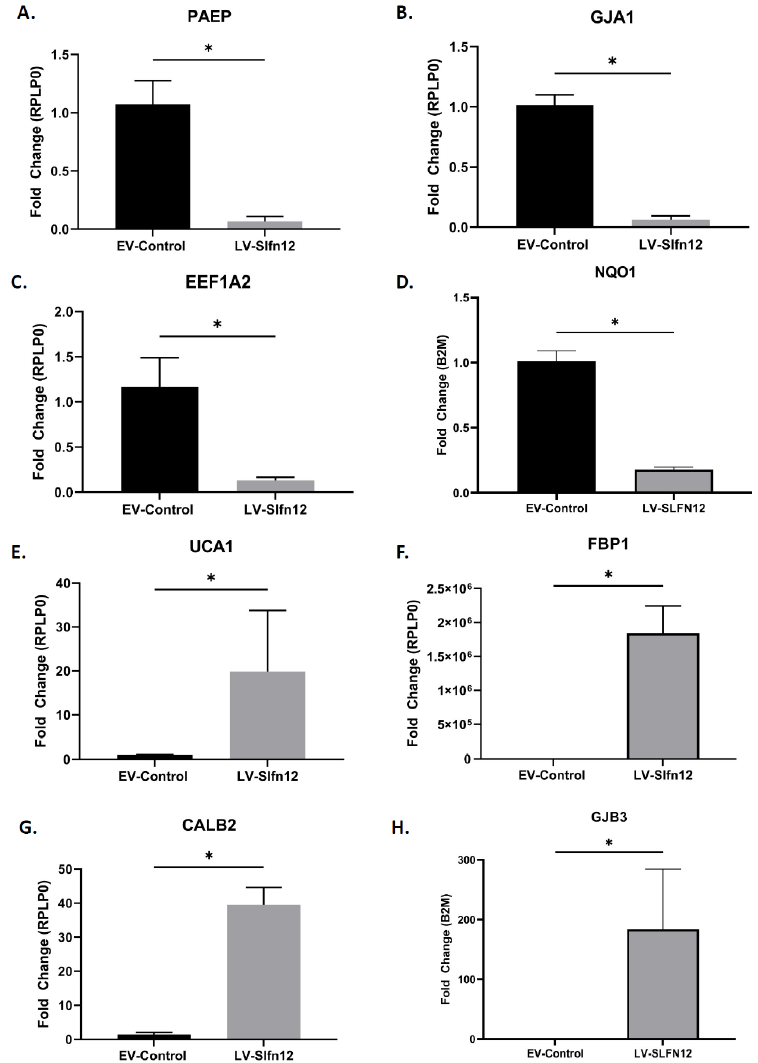
Figure 10. Conformation qPCR analysis of SLFN12 signature genes for EV-control and LV-SLFN12 including: ( A ) PAEP, ( B ) GJA1, ( C ) EEF1A2, ( D ) NQO1, ( E ) UCA1, ( F ) FBP1, ( G ) CALB2, and ( H ) GJB3. RPLP0 or B2M was used as a reference gene (n = 4 – 5, * p < 0.01). Data are expressed as mean ± SEM.